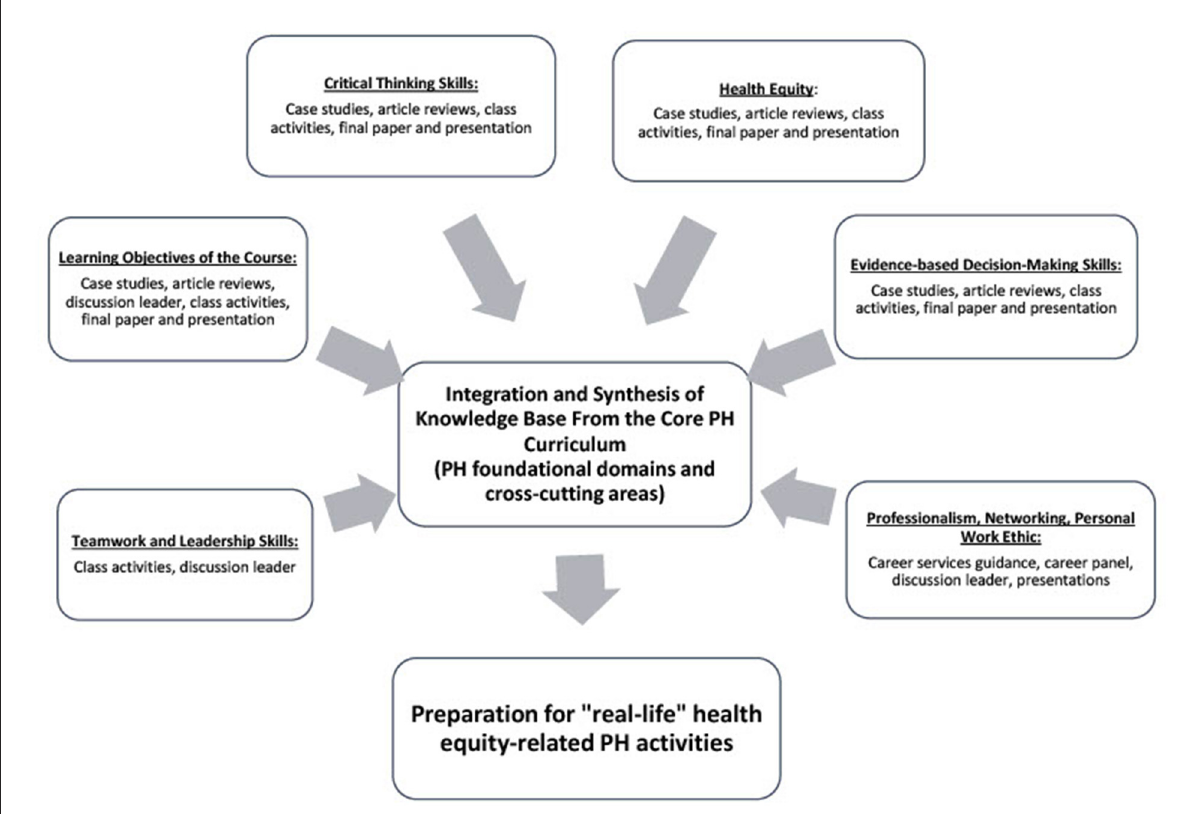
FIGURE1 Model utilized in the modern public health problems and solutions class*. Adapted from Andreasen